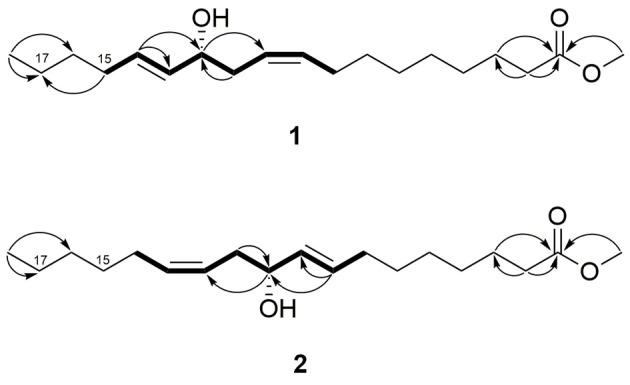
1H-1H COSY (bold bonds) and selected 1H-13C HMBC (arrows, proton to carbon) correlations of 1 and 2.